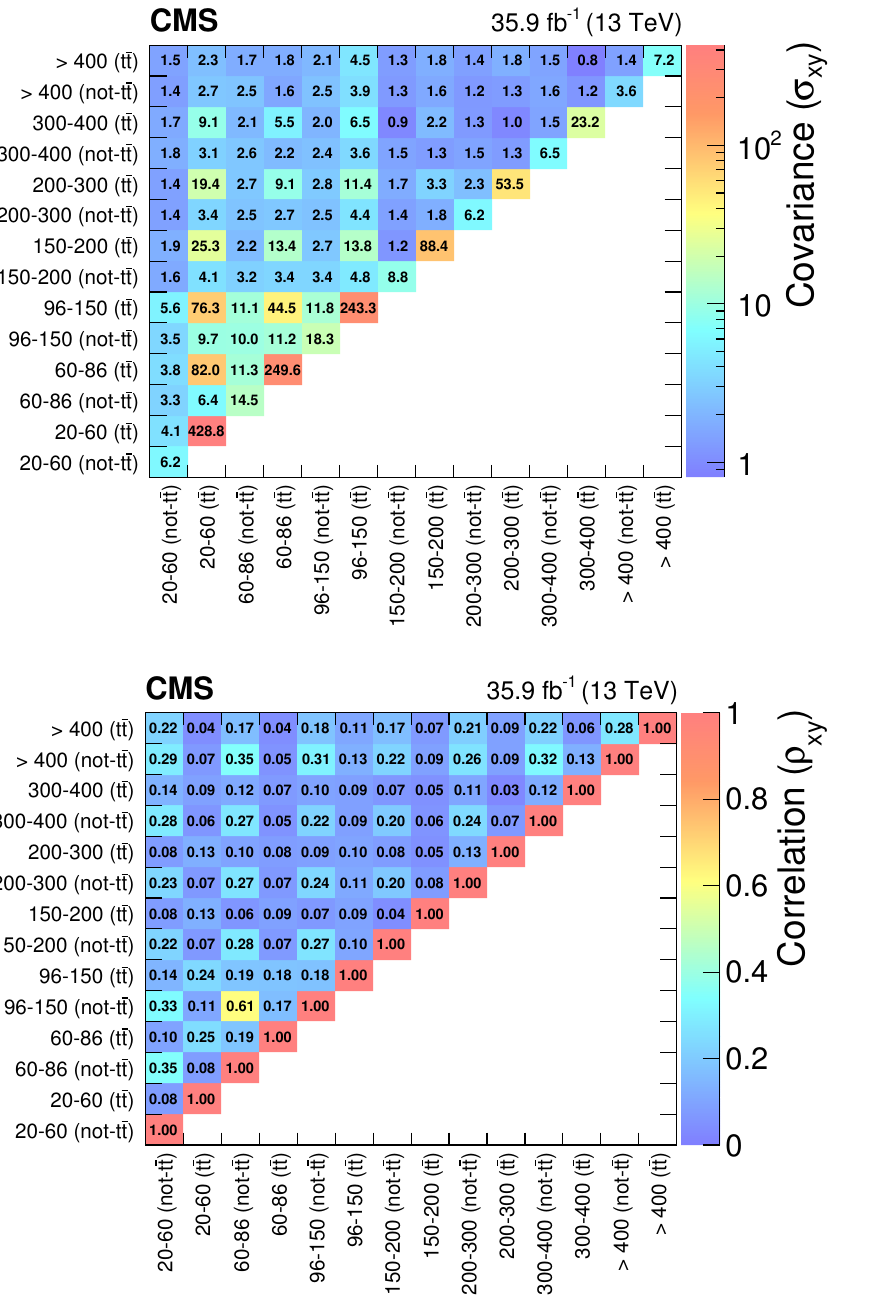
Figure 13 . The covariance (upper) and correlation (lower) matrices for the background predictions in the edge strong-production SRs. The matrices are symmetric, but only the entries along and above the diagonal are shown for